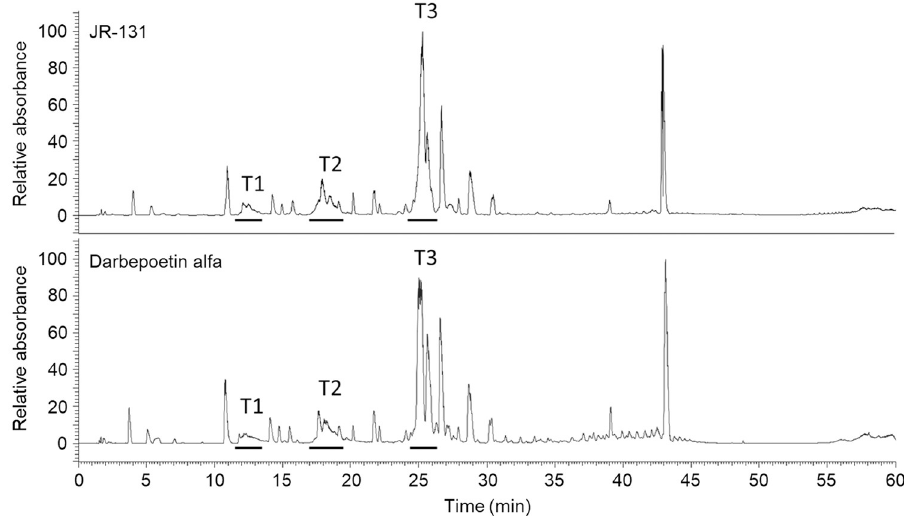
Fig 5. Total ion chromatograms of trypsin/endoproteinase Glu-C-digested JR-131 (upper) and darbepoetin alfa (lower). Fractions from retention times 11.5 to 13.5 min (T1), 17.0 to 19.5 min (T2), and 24.0 to 26.5 min (T3) were subjected to mass spectrometric profiling (S2A Fig for T1, S2B Fig for T2, and S2C Fig for T3).